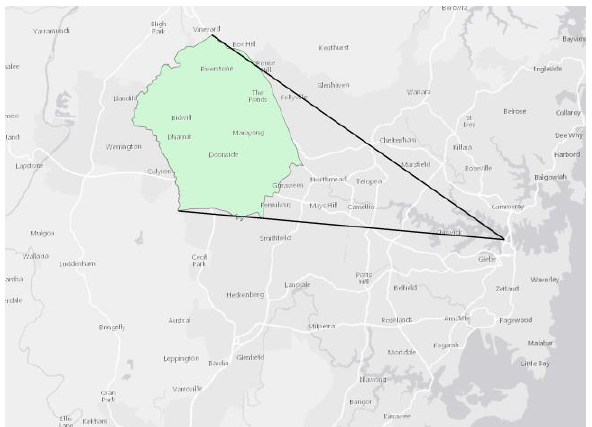
Figure 5. Blacktown area (lines indicate the location of Sydney